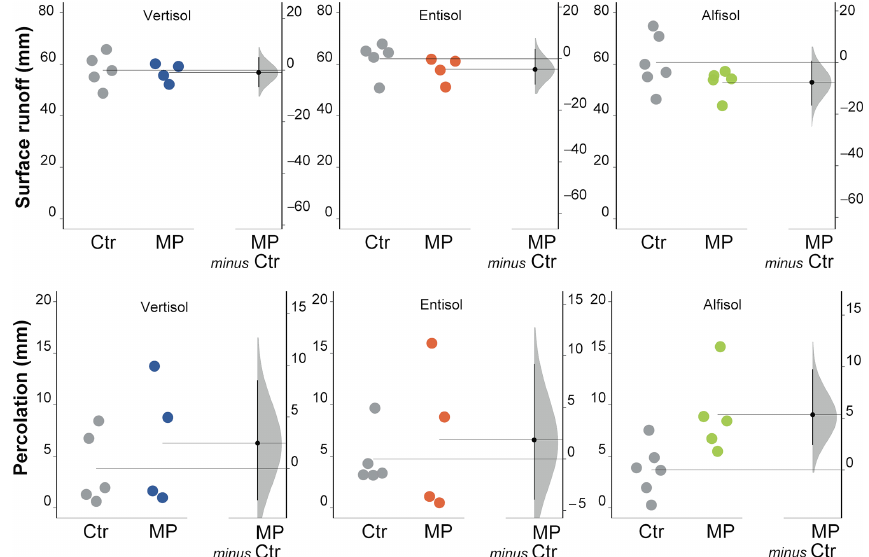
Figure 7. Surface runoff and percolation. Raw data of control (Ctr, gray dots) and polyester MP fibers added treatment (MP, colored dots) are shown in the plot for each soil. The filled curve indicates the resampled distribution of the mean differences ( (cid:49) ), given the observed data. Horizontally aligned with the mean of the test group, (cid:49) is indicated by the black circle. The 95% confidence interval of (cid:49) is illustrated by the black vertical line.